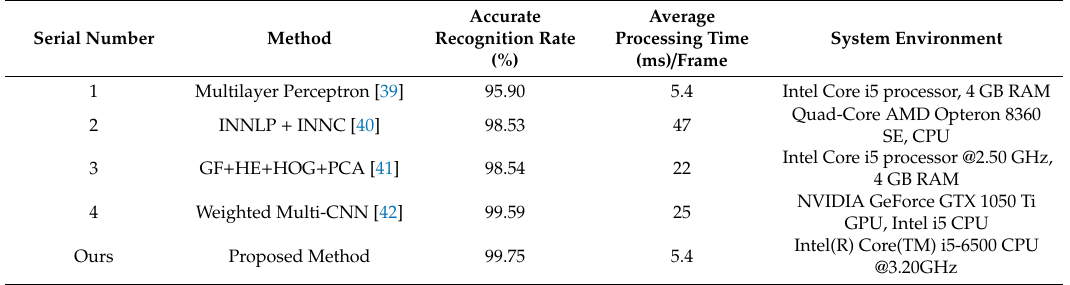
Table 4. The comparison of statistics in algorithm performance based on the GTSRB